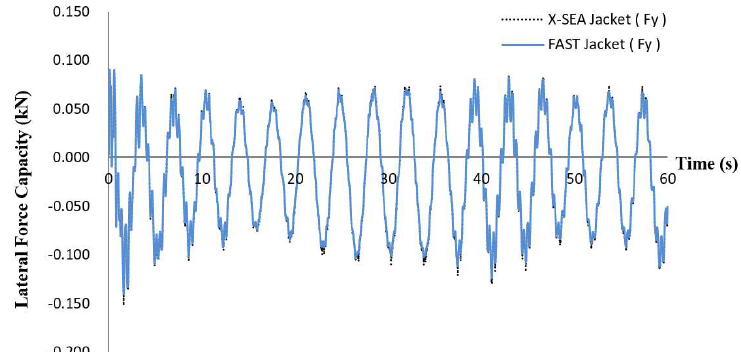
Figure 6. Comparison of the dynamic lateral reaction force capacity on the jacket support structure in the y-direction resulted from X-SEA and FAST v8 programs.